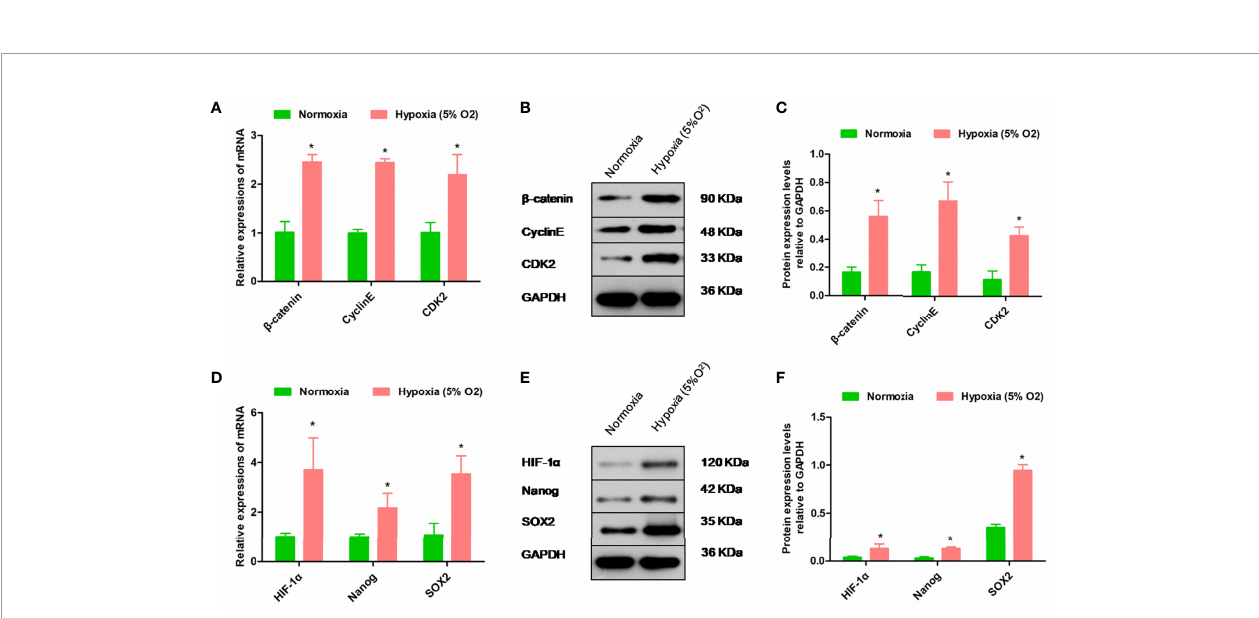
FIGURE 5 | Hypoxia regulates the expressions of cycle-related and self-renewal-related molecules. (A – C) mRNA and protein expression levels of b -catenin , Cyclin E , and CDK2 in rPBMSCs treated under normoxic and hypoxic (5% O 2 ) conditions for 5 days. (D – F) mRNA and protein expression levels of HIF-1 a , Nanog , and SOX2 in rPBMSCs treated under normoxic and hypoxic (5% O 2 ) conditions for 24 h. All data are presented as means ± SEM. P < 0. 05; ∗ vs control group. rPBMSCs, rat peripheral blood-derived mesenchymal stromal cells; HIF-1 a , hypoxia-inducible factor 1 a